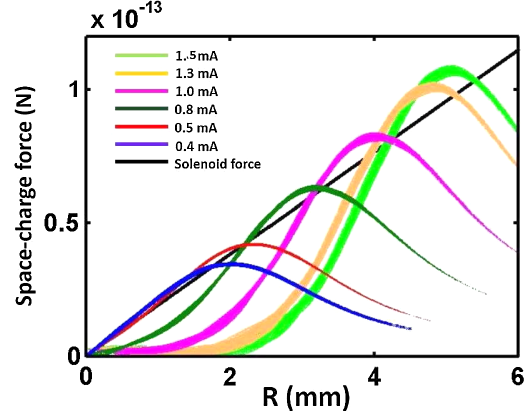
FIG. 6. Variation of the space-charge force along the radial direction for a Gaussian beam for different beam current super- posed with the solenoid force along the radial direction, at the point of formation of the